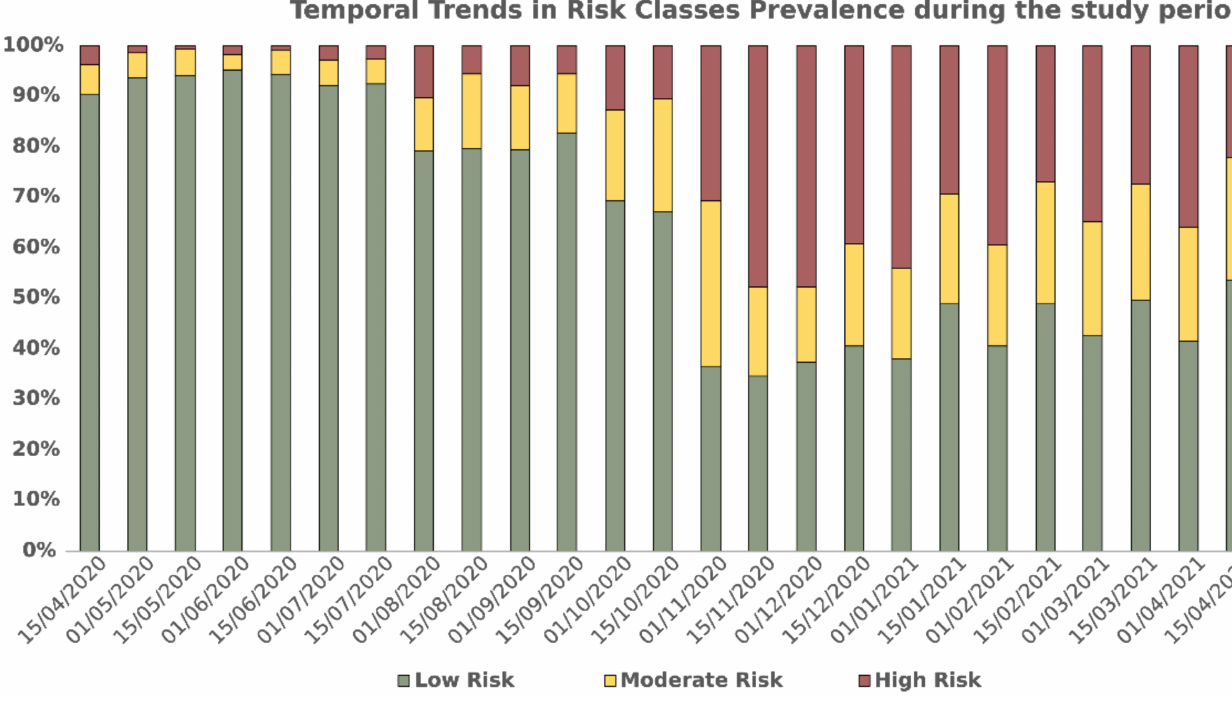
Figure 2. Number of dialysis clinics at the validation dates. Colors denote risk categories: Red, high > 12.5%; Yellow, medium 1.5% < x ≤ 12.5%; Green, low ≤ 1.5%.